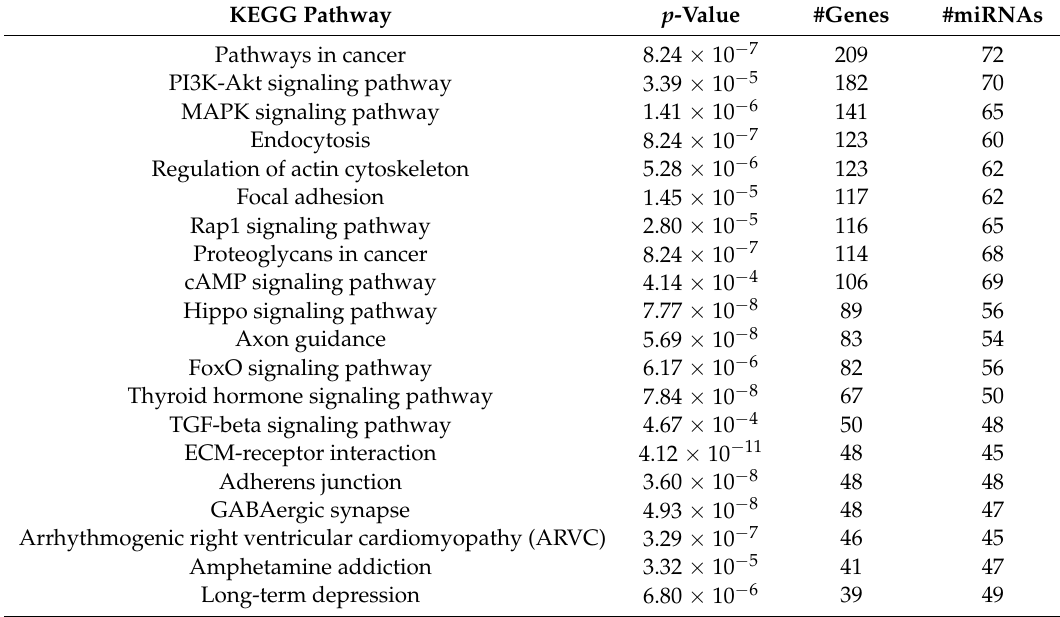
Table 5. Top 20 KEGG pathways from enrichment analysis of down-regulated miRNAs in SHH MB CSC. The entire table is reported in Table